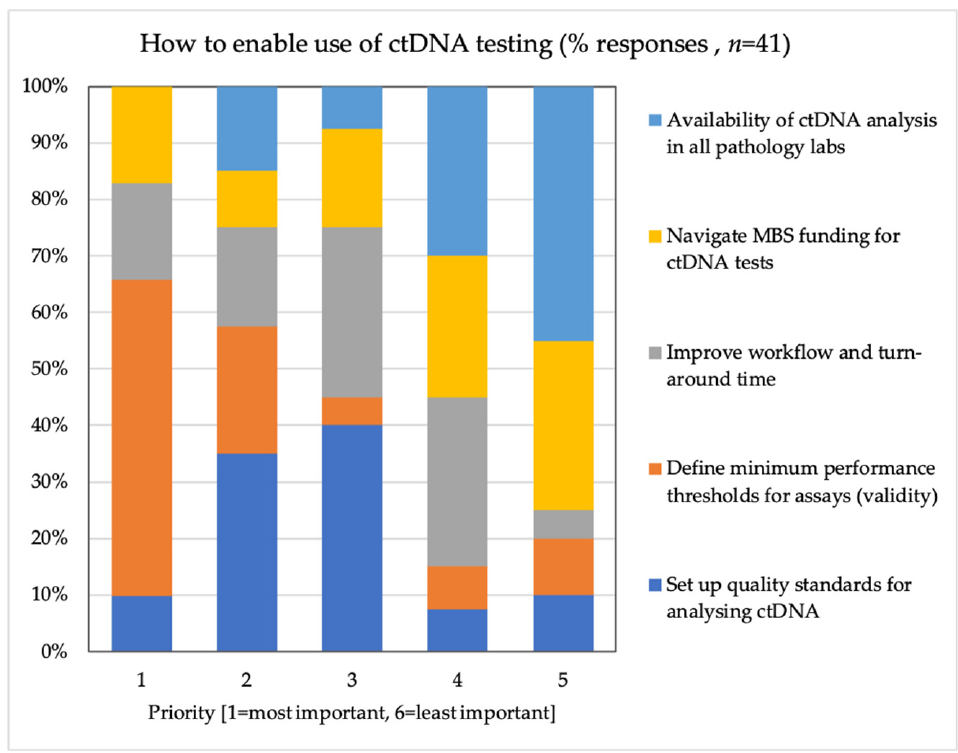
Figure 3. Results of ranking 5 statements related to clinical use of ctDNA.